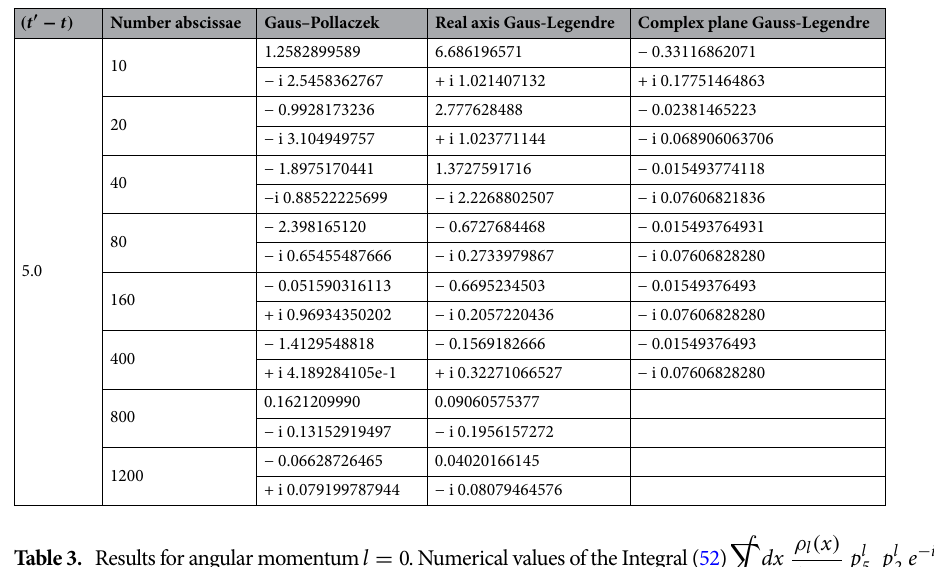
Table 3. Results for angular momentum l = 0 . Numerical values of the Integral (52) t , (z=1, (cid:31) = 2.01), evaluated using theGauss–Pollaczek quadrature (column 3), with l = 0 for different values of t ′ − Gauss–Legendre quadrature (column 4) along the real axis and as a contour integral with the Gauss–Legendre quadrature (column 5) and, in column 4 and 5, the value of the sum over the bound states is added to enable comparison with column